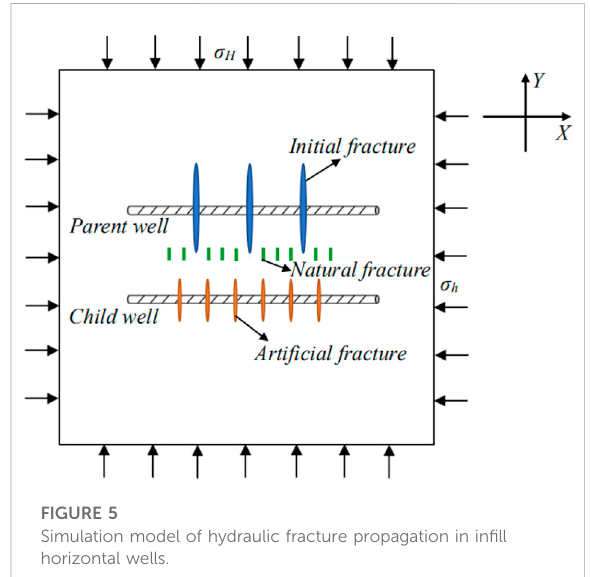
FIGURE 5 Simulation model of hydraulic fracture propagation in in fi ll horizontal wells.